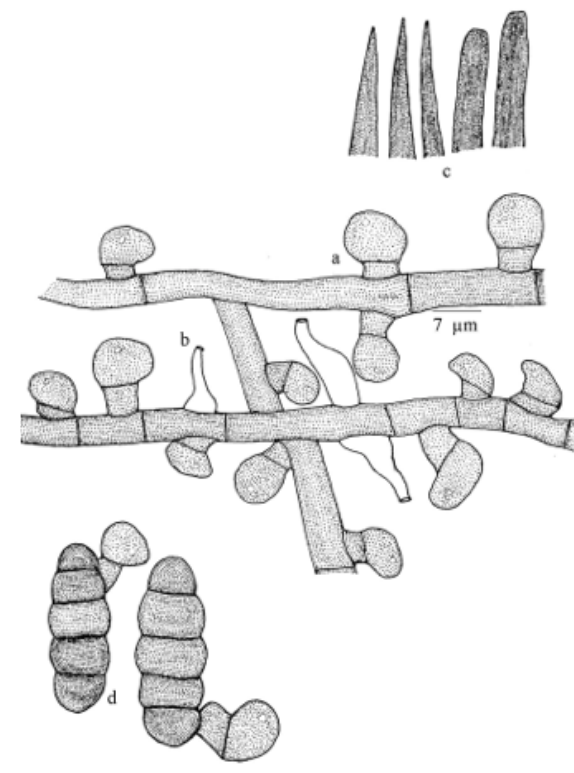
Figure 94. Meliola malacotricha a - Appressorium; b - Phialide; c - Apical portion of mycelial setae; d -